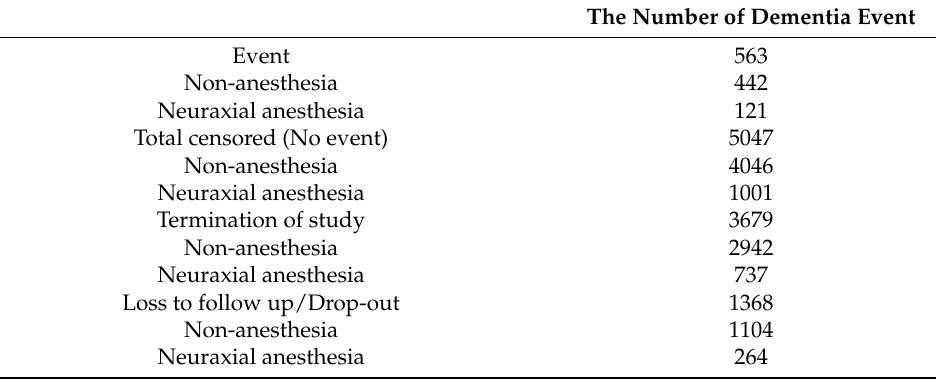
Table A2. Description of time to event and censored